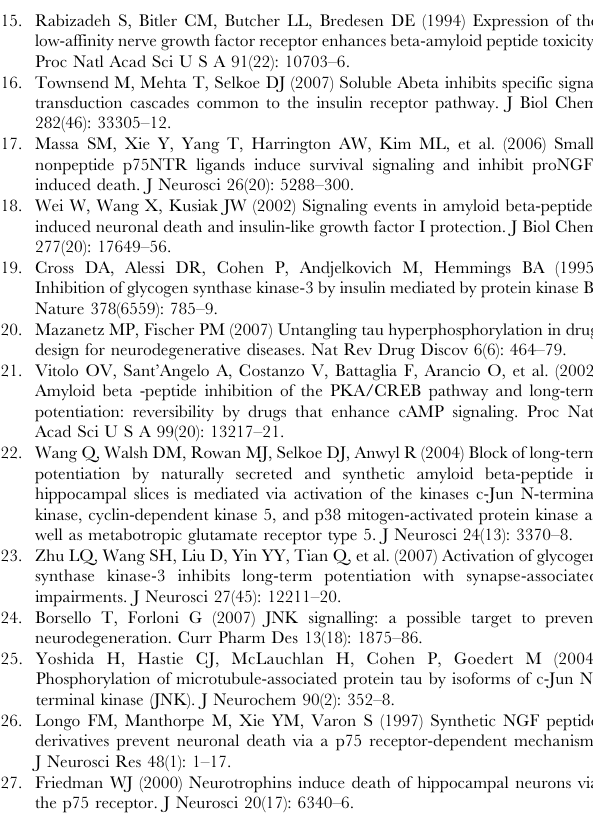
Figure S4 Illustration of neurite curvature quantitation. As described in Methods, neurites were traced manually in the form of a series of short vectors (small arrows along neurites) to